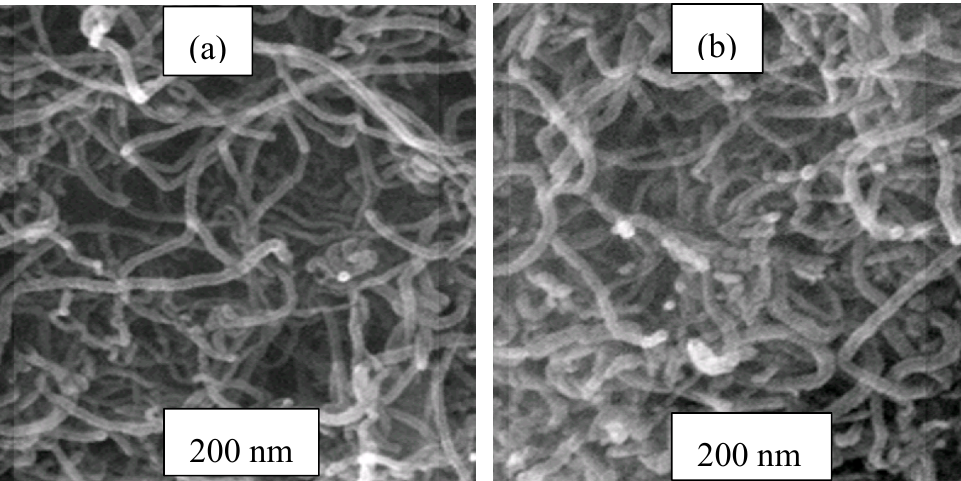
Figure 5. SEM micrographs of ( a ) synthesized CNT, and ( b ) h -BN-CNT showing a rough and scraggy surface.